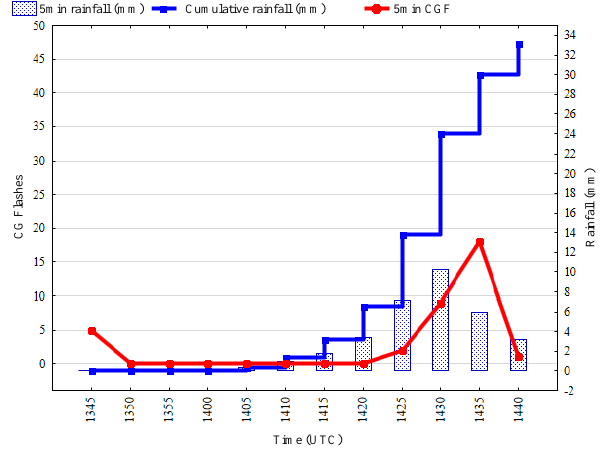
Figure 17. Critical interval time series for debris flow event of 28 July 1999. This is an event from the HL group and debris flow initiation was observed at 14:40UTC.